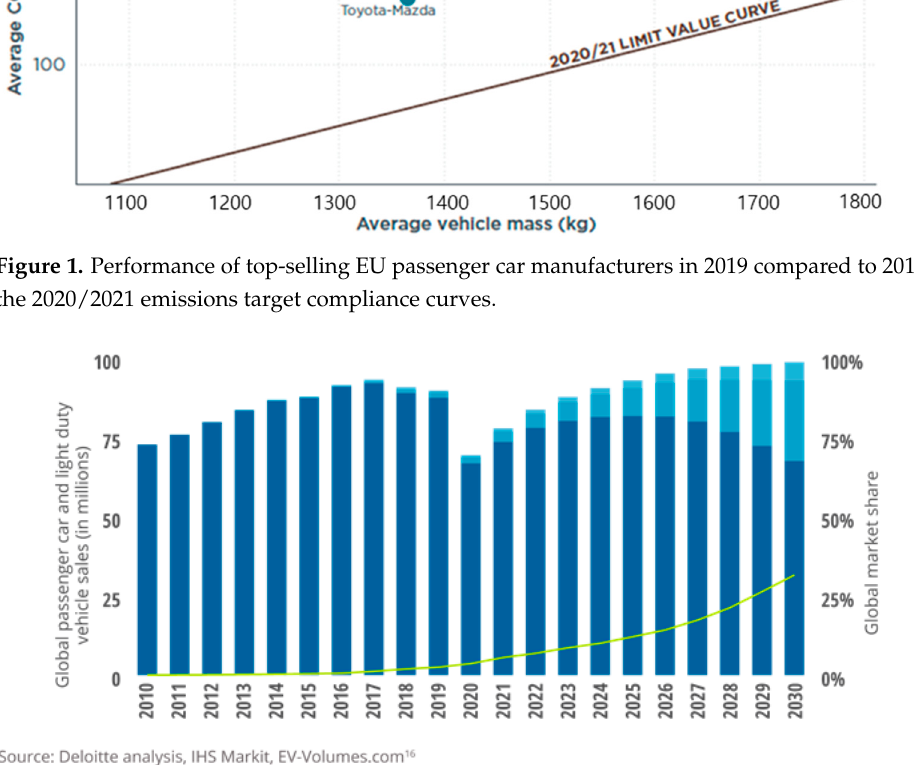
Figure 2. Outlook for annual global passenger-car and light-duty vehicle sales, up to 2030.